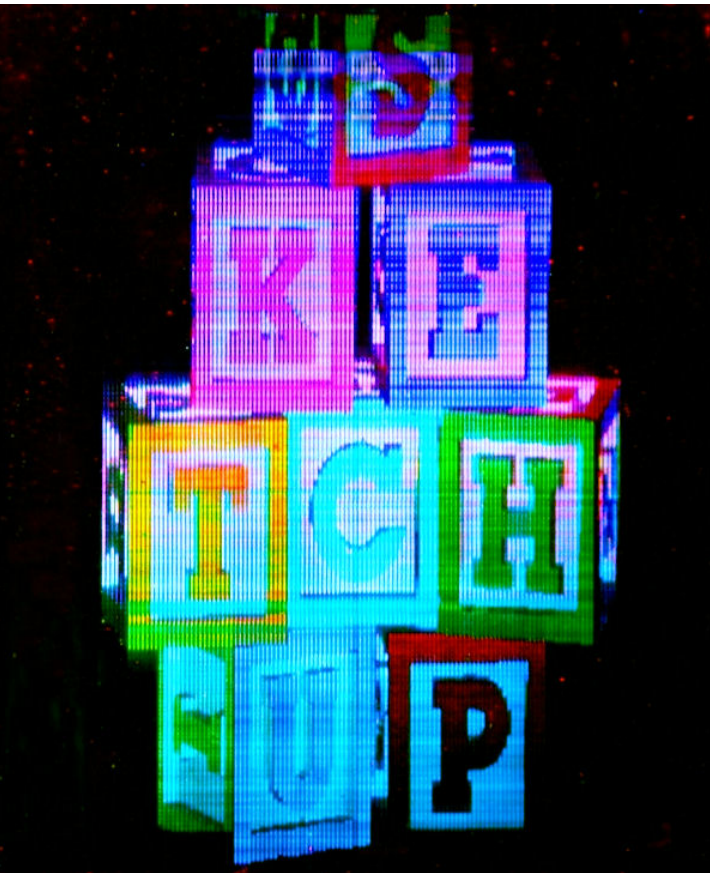
Figure 9. Picture of a full color (red, green, and blue) holographic stereogram recorded in photore- fractive polymer by taking advantage of the symmetry and polarization of the recording beams, as described in the text. The material composition was TPD:CAAN/FDCST:BBP:PCBP